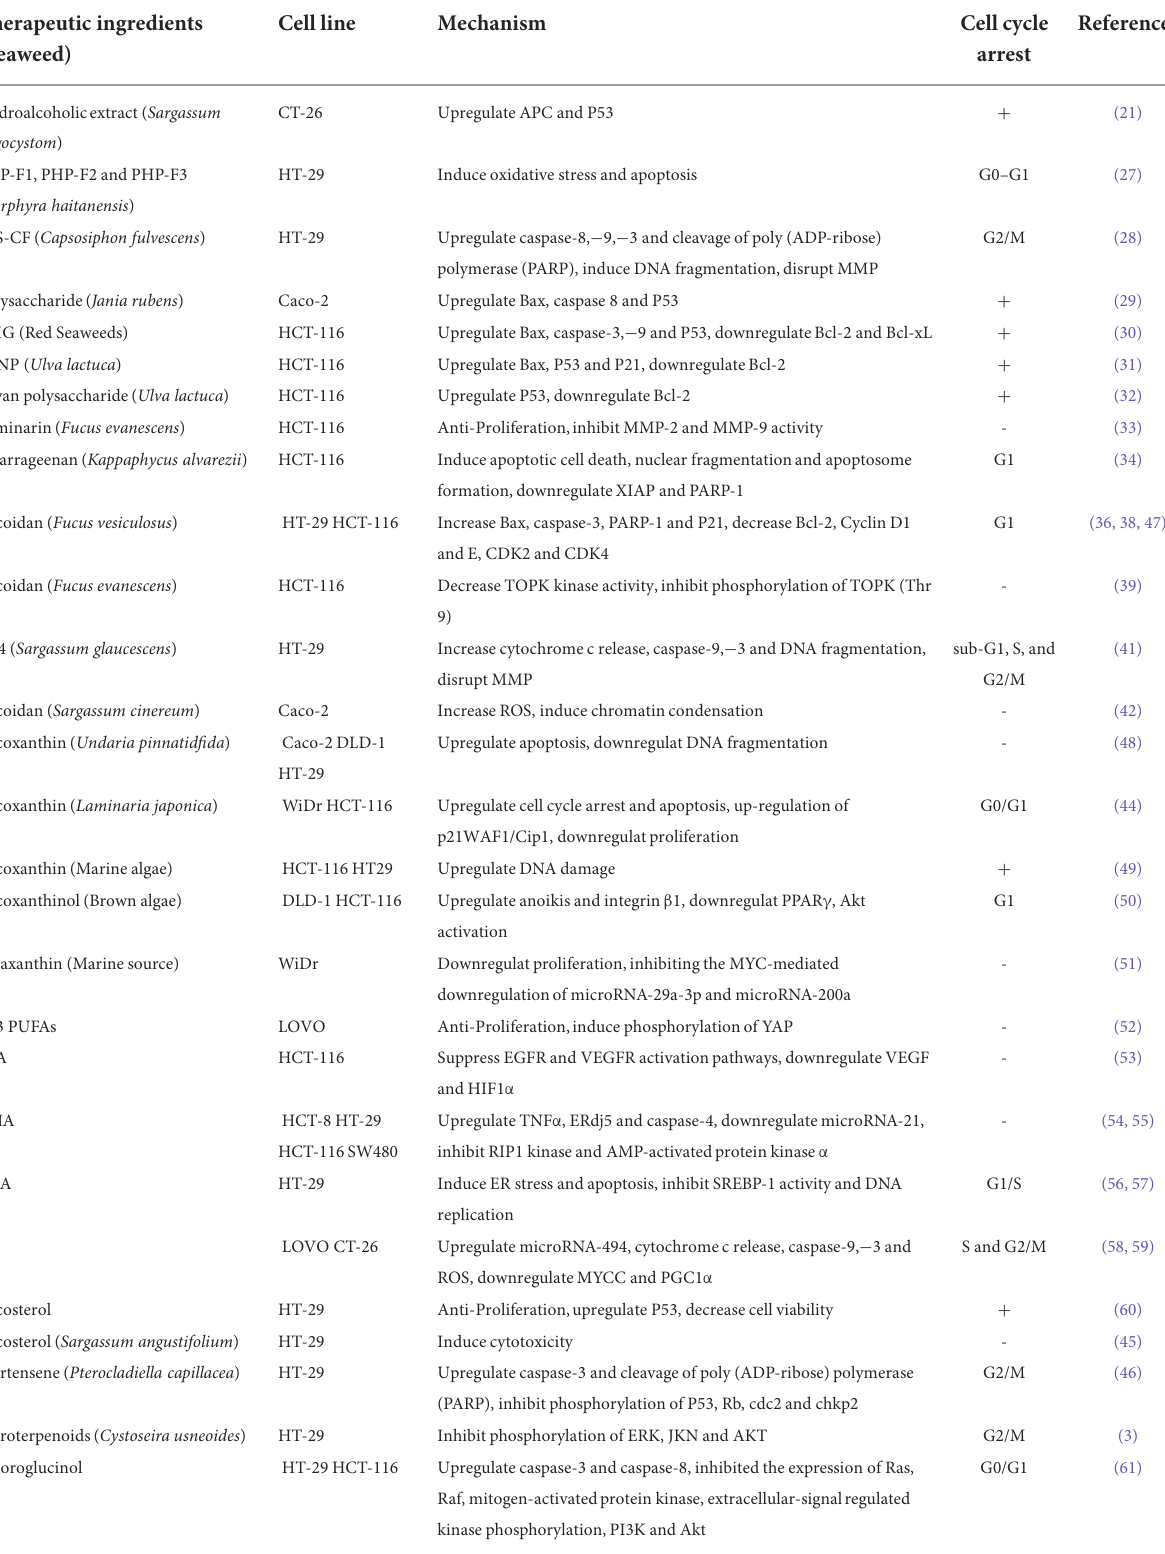
TABLE 2 Properties of active components isolated from seaweed against colorectal cancer. Therapeutic